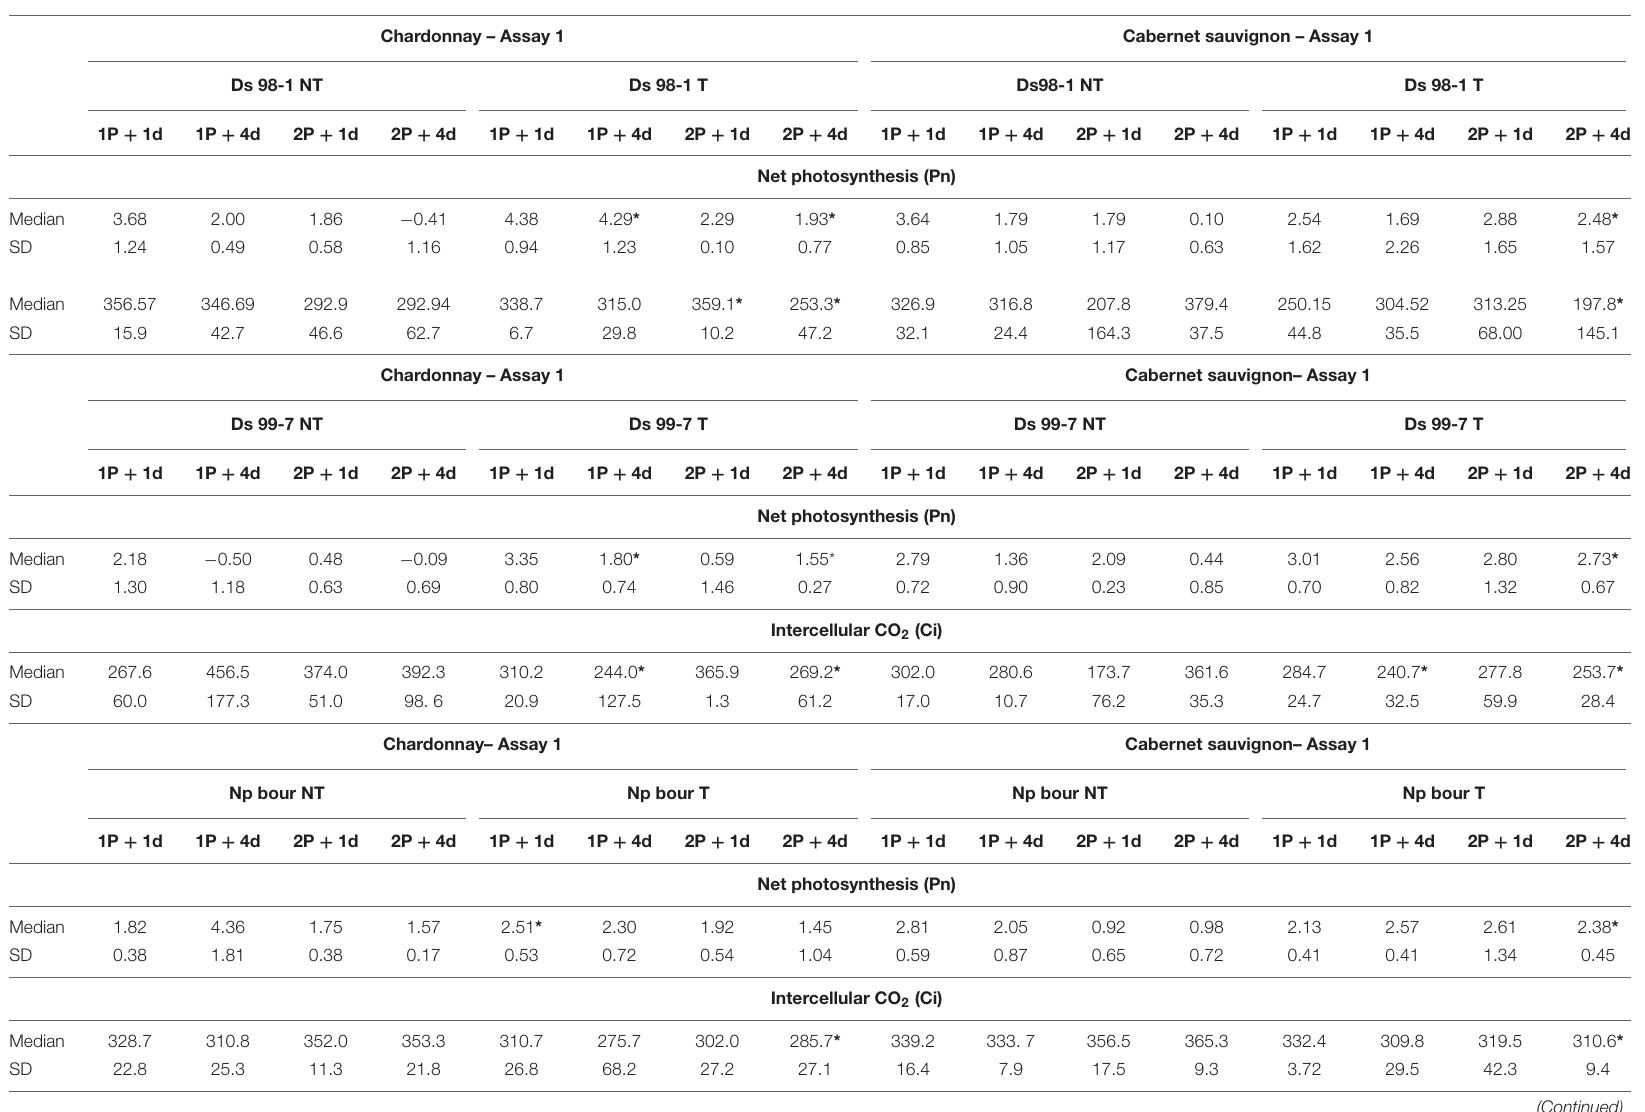
TABLE 5 | Photosynthetic parameters (Pn and Ci) recorded during Assay 1 one ( + 1 d) and four ( + 4 d) days after each post infection treatment on grapevines “Chardonnay” and “Cabernet sauvignon” artificially inoculated with Botryosphaeria-dieback